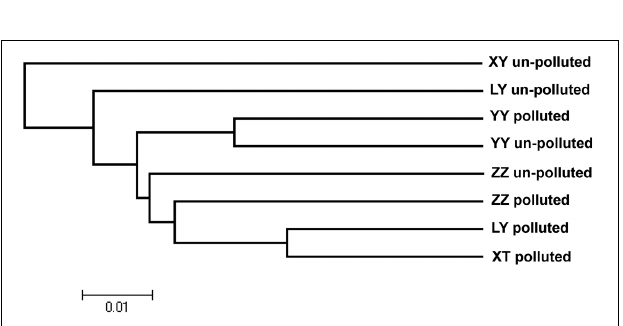
FIGURE 5 | Dendrogram of genetic relationships among populations. The neighbor-joining method was applied to an average squared distance matrix among populations. Scale bar indicates average squared distance. LY, ZZ, XT, and YY mean Liuyang, Zhuzhou, Xiangtan, and Yueyang City,